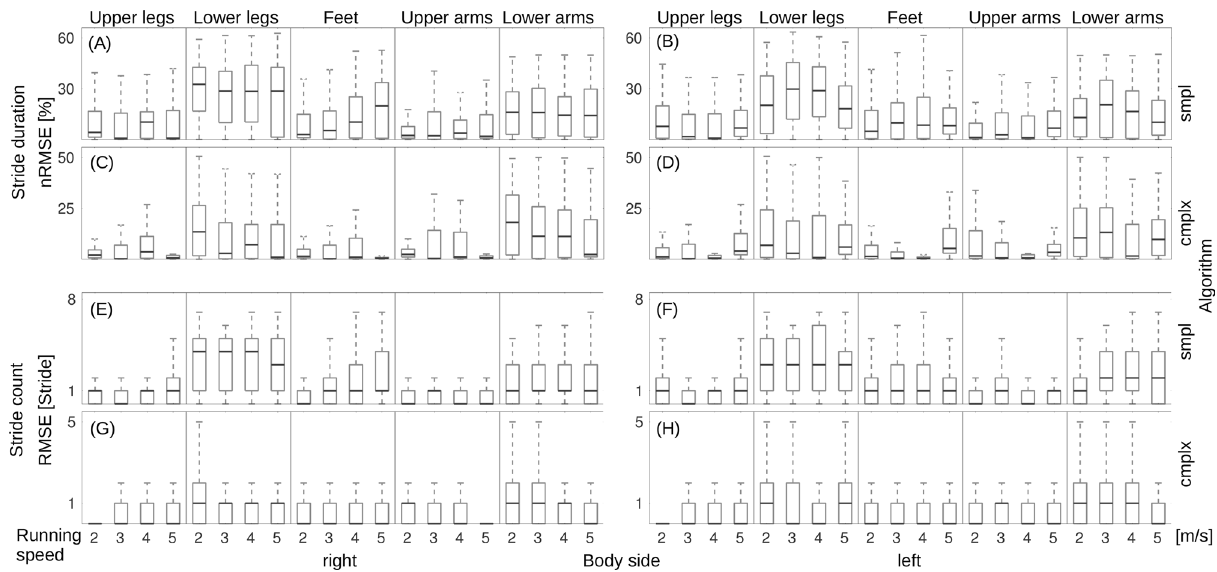
Figure 3. Boxplots of the error analysis for markers stride duration and stride count at various body positions averaged across all athletes: ( A , B ) nRMSE for stride duration, smpl algorithm, right and left body sides. ( C , D ) nRMSE for stride duration, cmplx algorithm, right and left body sides. ( E , F ) RMSE for stride count, smpl algorithm, right and left body sides. ( G,H ) RMSE for stride count, cmplx algorithm, right and left body